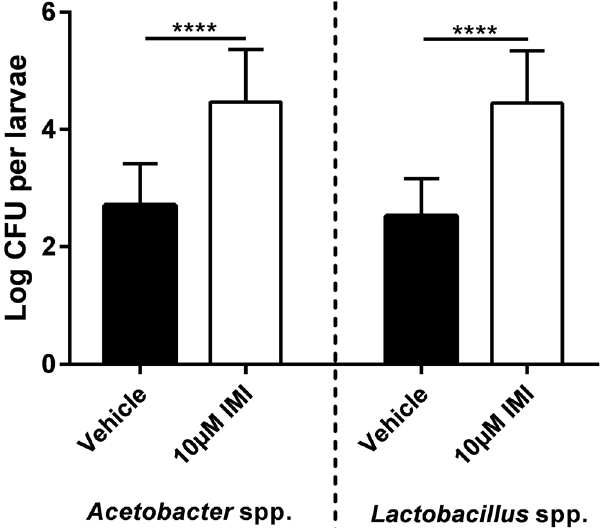
Figure 2. IMI exposure results in an increased abundance of indigenous Acetobacter and Lactobacillus spp. in D . melanogaster . Third-instar larvae that were reared on food containing vehicle or 10 μ M IMI were surface- sterilized, homogenized, plated on selective medium, and incubated at 37 °C. Colony forming units (CFU) were subsequently enumerated after 48 h of incubation. Mean ± standard deviation (unpaired, two-tailed t-tests) of 3 independent experiments (n = 15 for each group). **** p <